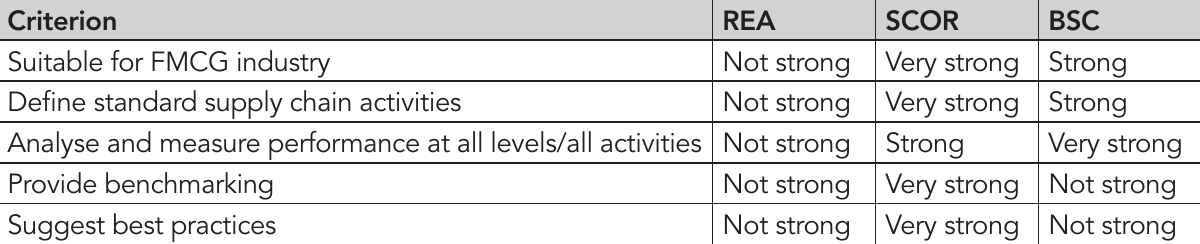
Table 2: Comparison criteria for the operational performance models Criterion REA SCOR BSC Suitable for FMCG industry Not strong Very strong Strong Define standard supply chain activities Not strong Very strong Strong Analyse and measure performance at all levels/all activities Not strong Strong Very strong Provide benchmarking Not strong Very strong Not strong Suggest best practices Not strong Very strong Not